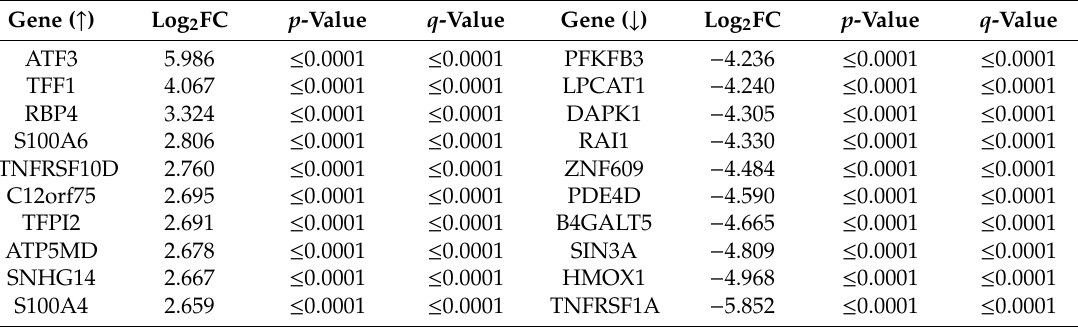
Table 1. Phenanthriplatin and cisplatin modulate gene regulation in A549 cells. Top 10 up- and downregulated DEGs for A549 phenanthriplatin versus A549 control. DEG data analysis: ( p ≤